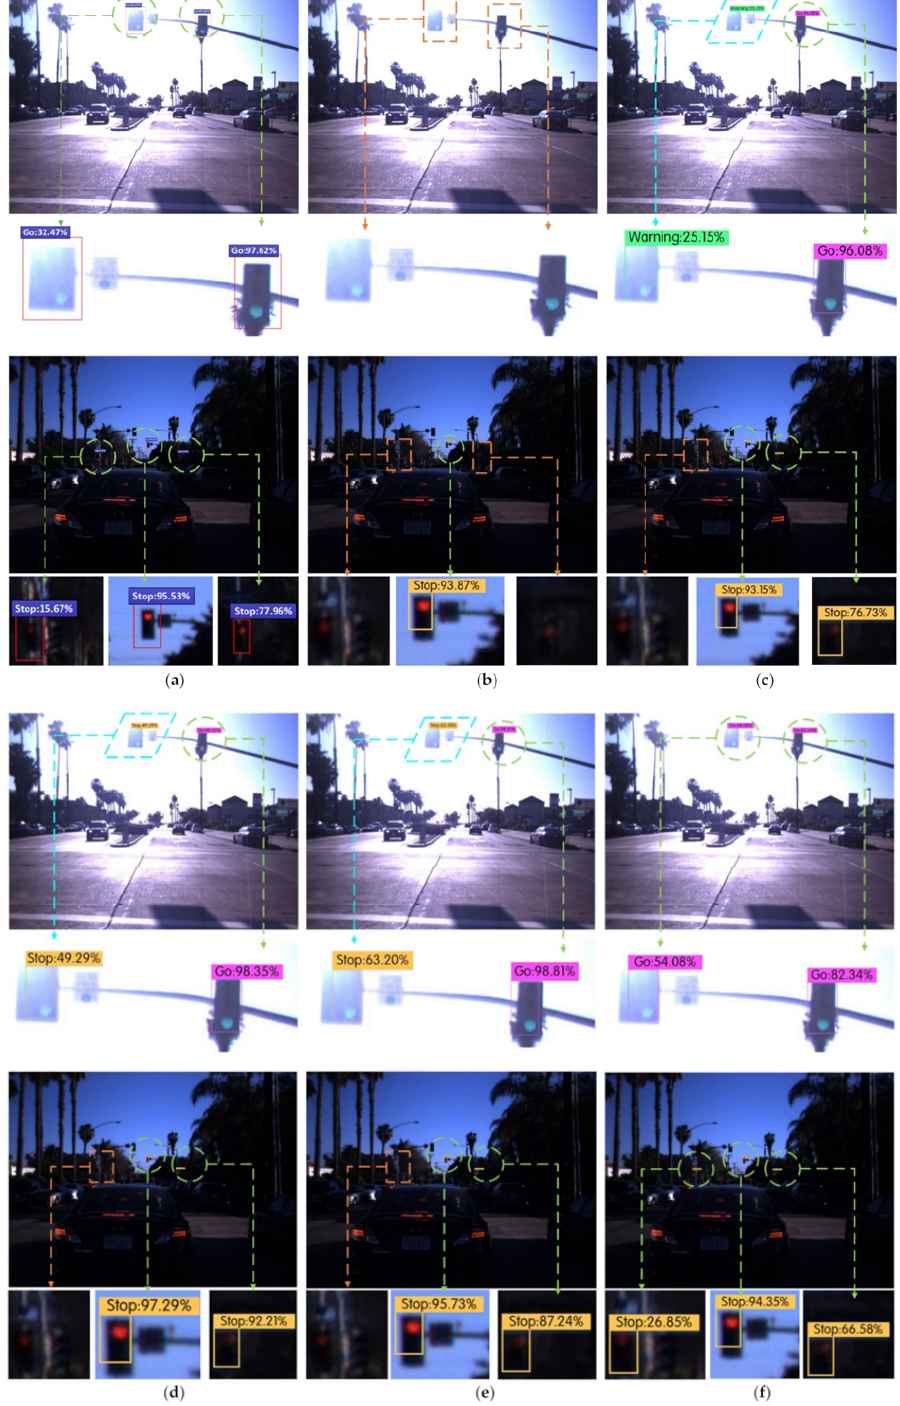
Figure 11. Comparison of recognition results using multiple algorithms for traffic lights in different scenarios in the LISA data set. ( a ) Faster R-CNN. ( b ) YOLOv3. ( c ) YOLOv4. ( d ) YOLOv4-v1. ( e ) YOLOv4-v2. ( f ) Improved